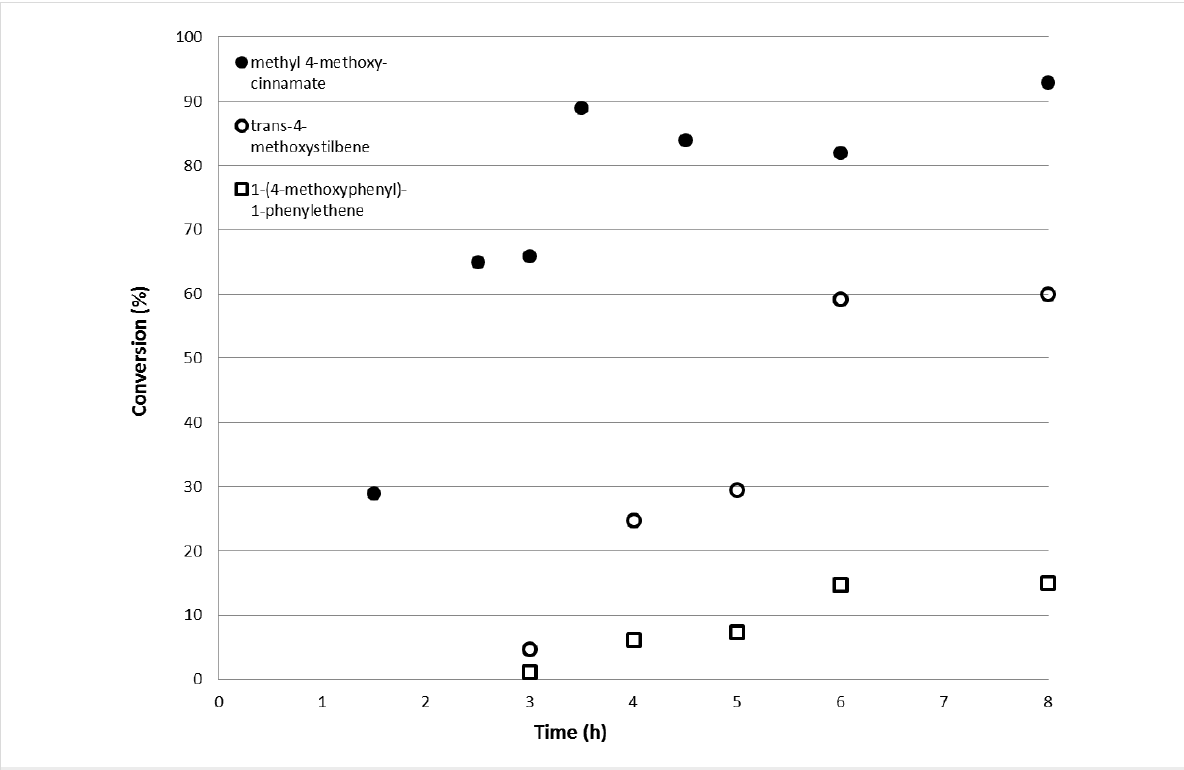
Figure 6: Conversion of 4-iodoanisole to methyl 4-methoxycinnamate ( ● ) at 155 °C and 200 bar as a function of reactor run time. The open symbols are the conversions to the different isomeric products for the reaction of 4-iodoanisole with styrene for